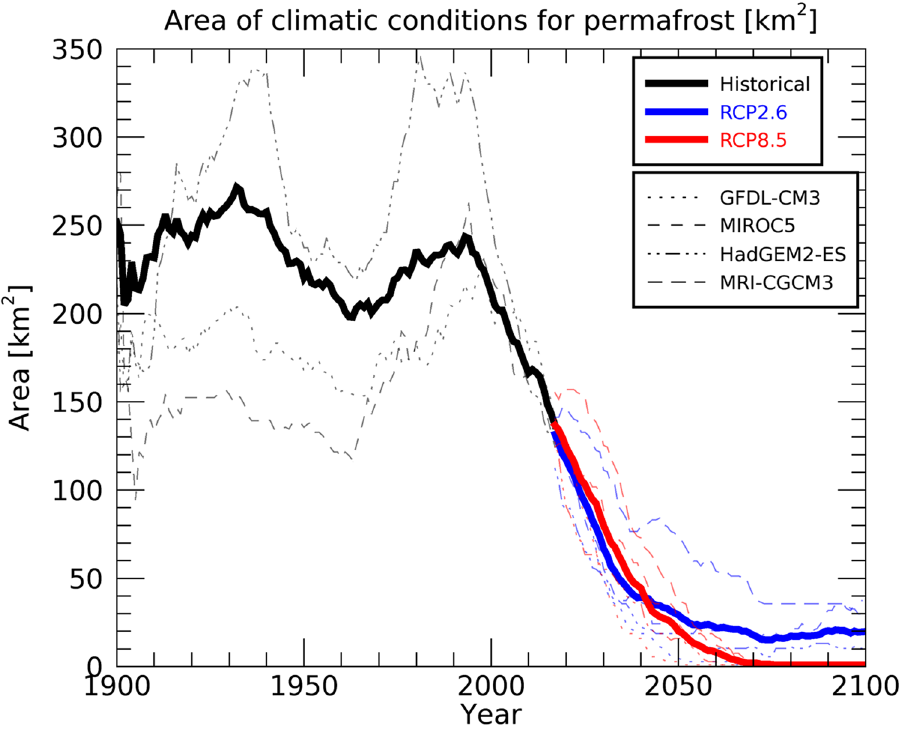
Figure 6. Time series of the area where climatic conditions are suitable for the maintenance of permafrost (environmentally conditioned permafrost, ECP) in the Daisetsu Mountains. Results of historical (black) and future projections under the RCP2.6 (blue) and RCP8.5 (red) scenarios are shown. Thin broken lines show the results obtained from the four bias-corrected climate scenarios based on different global climate models, and the thick line is the average of the results using the four bias-corrected scenarios. The ECP region was calculated using the average value of the freezing and thawing indices over a 30-year